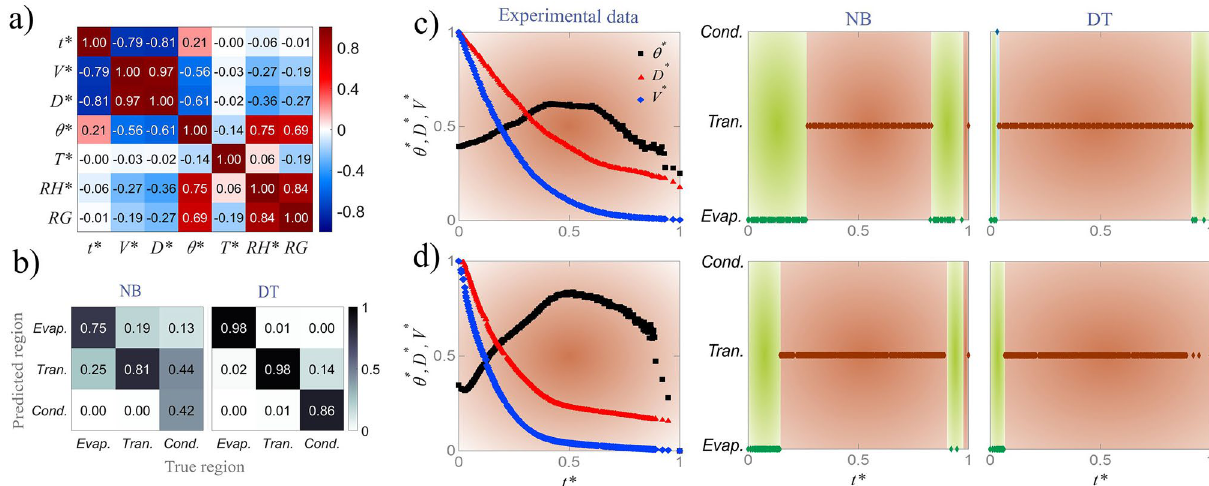
Figure 2. Results of regime classification: ( a ) correlation matrix for parameters in droplet evaporation; ( b ) results of test set for regime detection illustrated with confusion matrices for Naïve Bayes (NB) and decision tree (DT) algorithms; ( c ) point-by-point validation results with NB and DT classifiers for regime detection ◦ with experimental data of droplet evaporation for RH = 80% and T = 35 C; ( d ) point-by-point results of estimation set with NB and DT classifiers for regime detection with experimental data of droplet evaporation for ◦ experiment #4 (RH = 75% and T = 25 C) in estimation set. The colors in ( c , d ) correspond to the regime colors used in Fig. 1b.